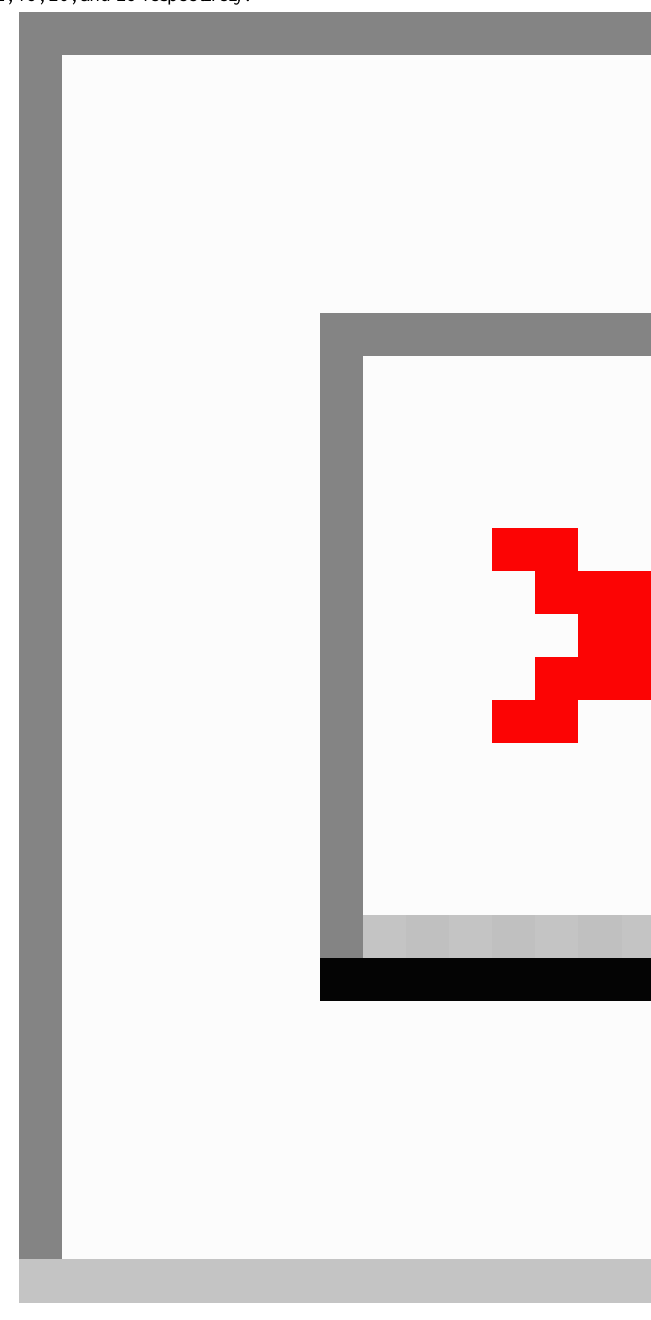
Figure 1. Average weight loss on Atkins diet reported in 3 clinical trials and Amazon reviews. Amazon data points were calculated by averaging reviews nearest the time points 1, 2, 3, 4, 5, 6, 9, 12 months. The numbers of reviews averaged to create the Amazon data points were 129, 60, 60, 23, 22, 19, 26, and 29